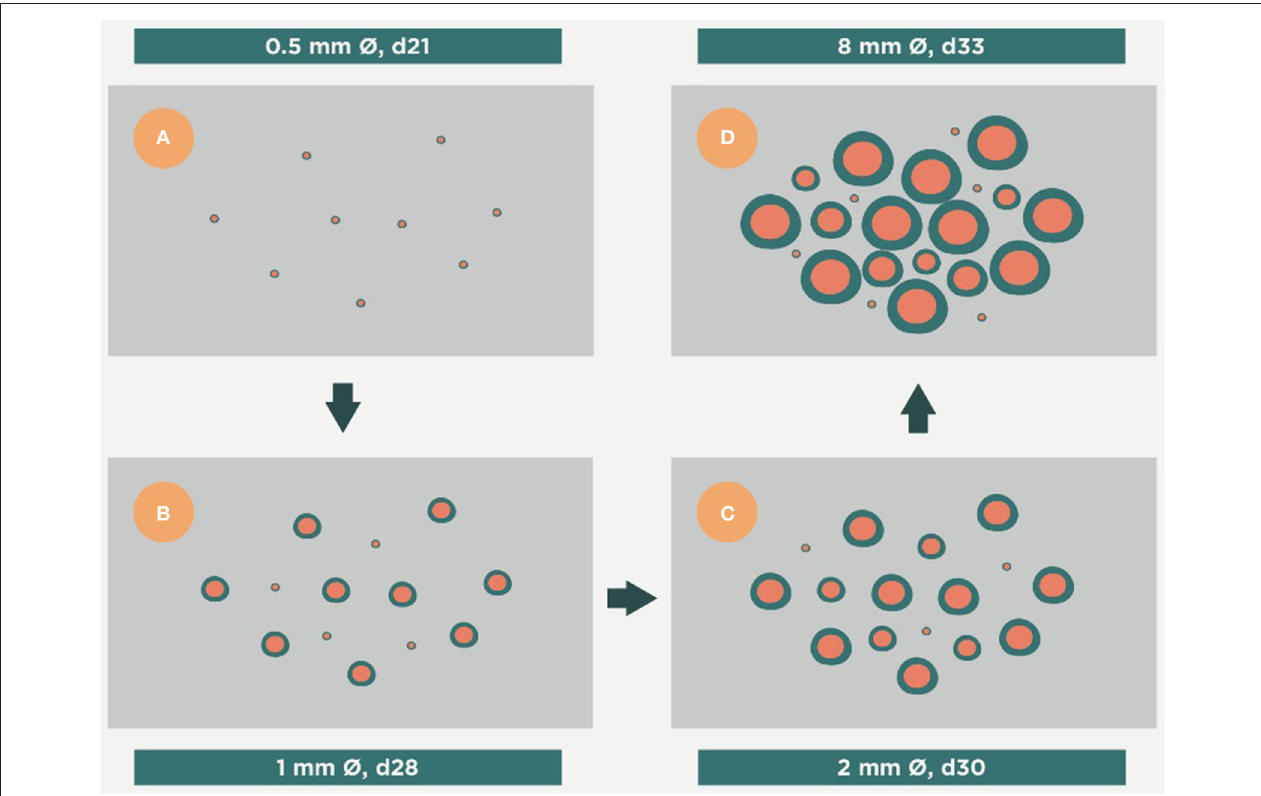
FIGURE 5 | Evolution of the infection toward active disease. An excess of Th17 allows massive infiltration of the lesions by PMNs. This causes a rapid growth in their size and the induction of secondary lesions (daughter lesions). Finally, these lesions coalesce, which results in the evolution of small granulomas ( < 1mm) to large infiltrations that can liquefact and cavitate, thus exceeding the ability of the interlobular septae to encapsulate them. Time period from (A–D) , days 21, 28, 30 and 33